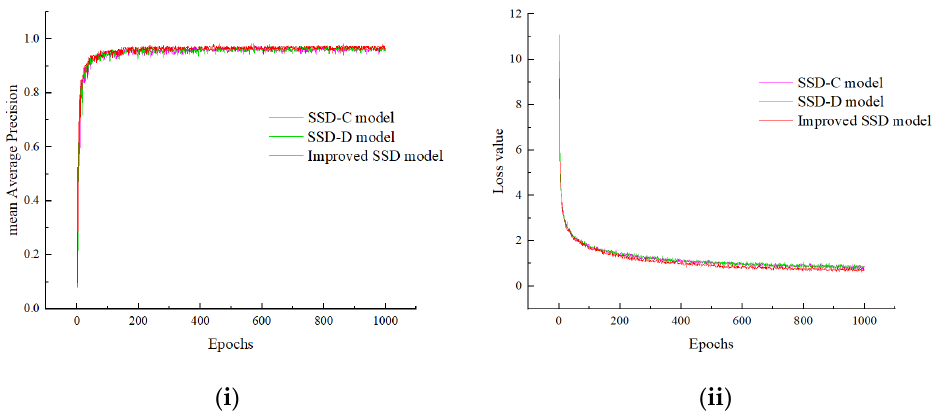
Figure 13. The average precision and loss value change curve in the comparison test of the improved SSD model structure. ( i ) mAP; ( ii ) Loss value.